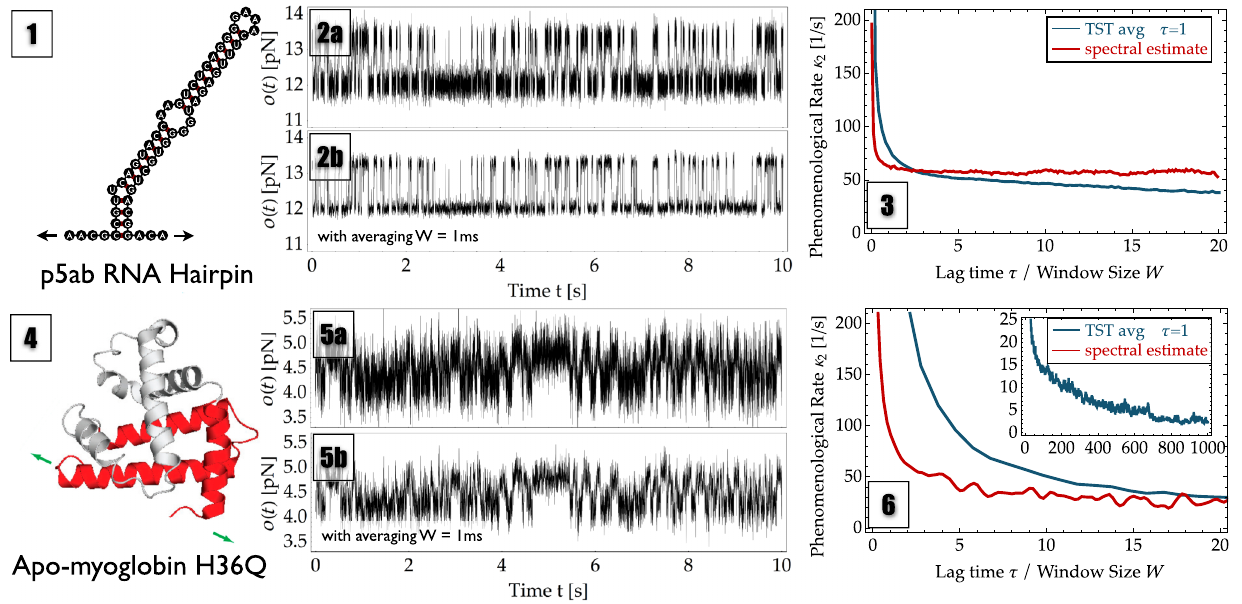
FIG. 3. Probed systems by optical tweezer experiments. Top: RNA hairpin p5ab. Bottom: H36Q mutant of sperm whale apo- myoglobin. Panels (1) and (4) show schematic views of the probed system in its native secondary or tertiary structure including the direction of the pulling force (green and black arrows). Panels (2) and (5) show the traces used for analysis. Row (a) reports the results when directly analyzing the measured 50 kHz data, while row (b) reports the results when analyzing data that has been binned to 1 kHz to reduce the noise amplitude. Panels (3) and (6) show the estimated phenomenological rates ˆ κ 2 for TPT (blue line) using different averaging window sizes W ( x axis) and spectral estimation (red line) for different lag times τ ( x axis). For apo-myoglobin, the inset displays the behavior of TST at large window sizes W , where the rate is systematically